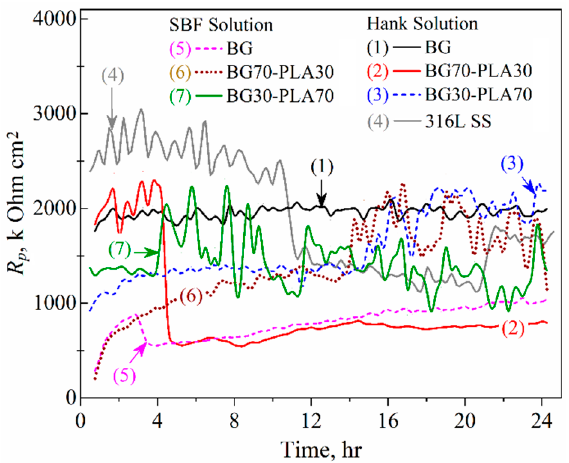
Table 7. Comparison of potential of corrosion between the samples evaluated in Hank’s and SBF solutions.